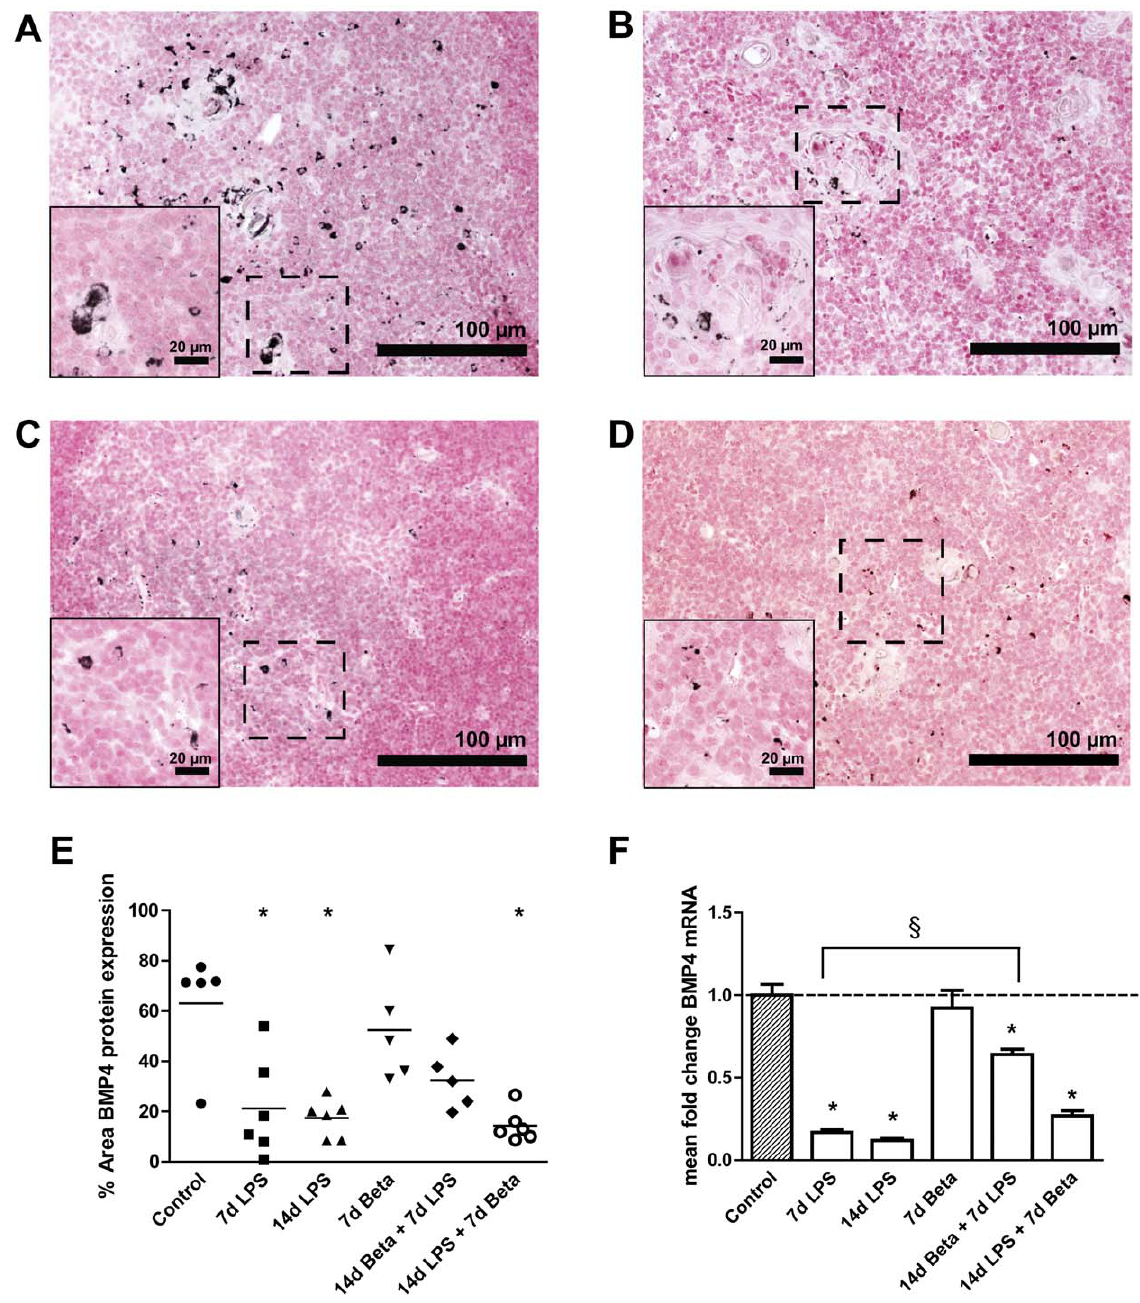
Figure 8. Bone morphogenetic protein 4 (BMP4) expression. Representative images for BMP4 expression in the thymus are shown for controls ( A ), 7 d LPS ( B ), 14 d LPS ( C ) and 14 d LPS + 7 d Beta group ( D ). E: BMP4 protein expression decreased in the 7 d and 14 d LPS and the 14 d LPS + 7 d Beta groups. F: BMP4 mRNA levels decreased 7 and 14 days after LPS exposure irrespective of betamethasone treatment. Magnification 200 6 ; magnification insert: 400 6 . * p , 0.05 versus controls and 1 p , 0.05 between experimental